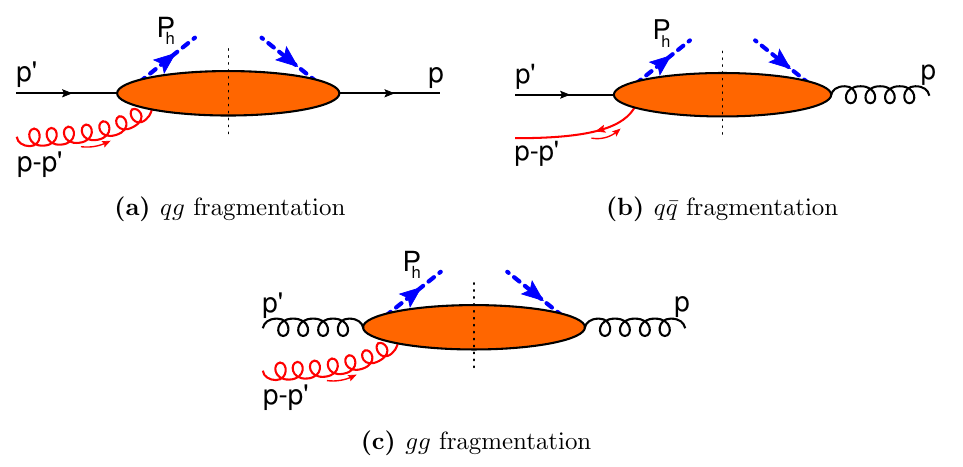
Figure 2. Diagrammatic representation of three-parton fragmentation